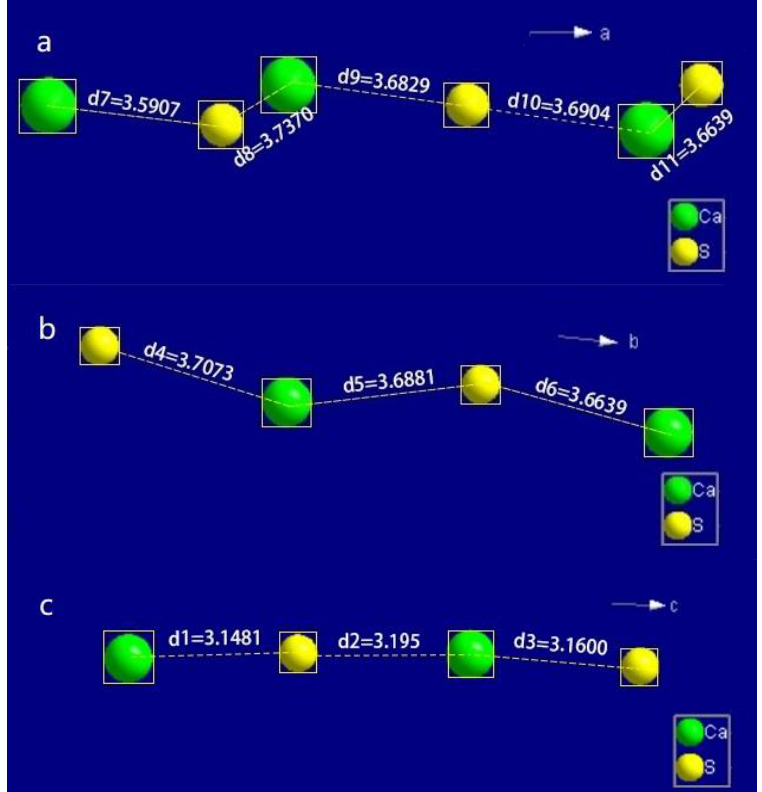
Figure 9. The distances between the Ca ions and the S atoms in the unit cell along ( a ) the a -axis, ( b ) the b -axis and ( c ) the c -axis.